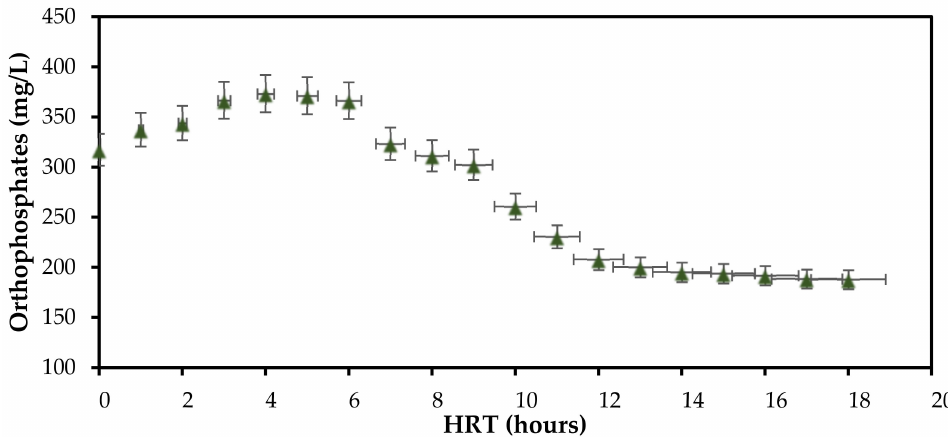
Figure 2. Orthophosphate concentration as a function of HRT